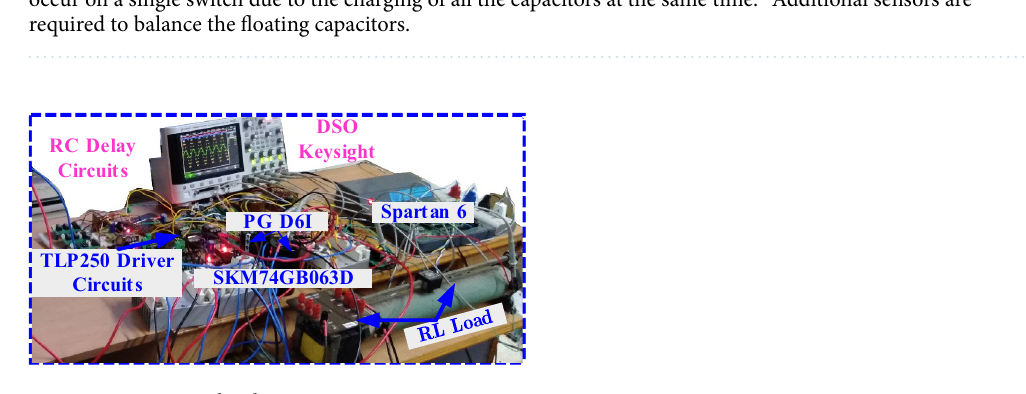
Figure 5. Prototype hardware setup.